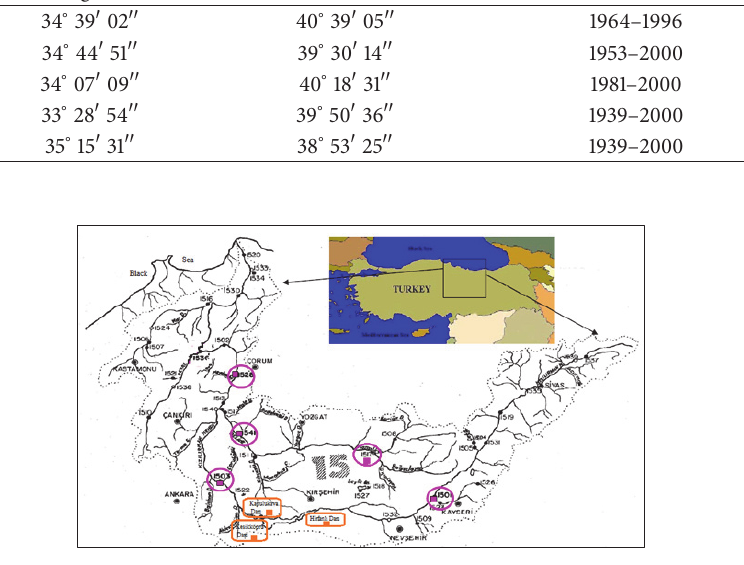
Figure 1: Gauges station schematic: (1) EIE1528; (2) EIE1541; (3) EIE1517; (4) EIE 1503; (5)